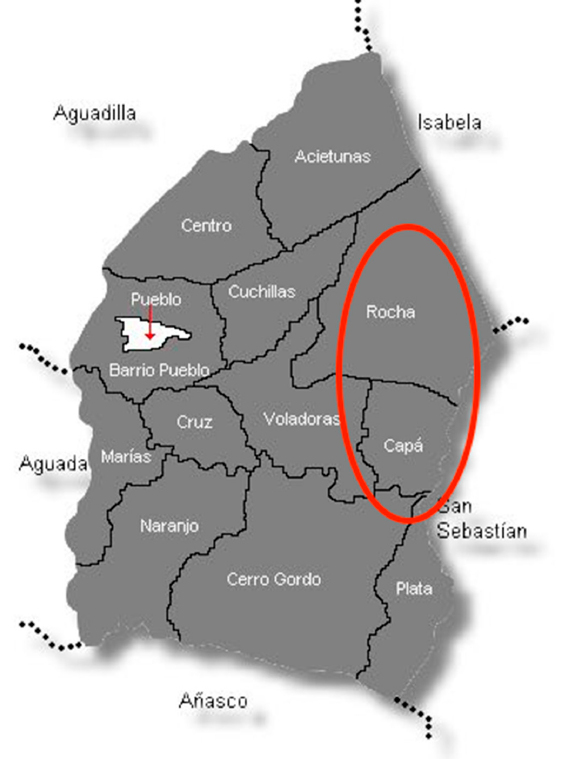
Figure 5. Municipality of Moca, Puerto Rico. The hacienda of the Lassalle family was located on the border between Barrios Rocha and Capa, as indicated by the oval. Map adapted from Boricua online.com.